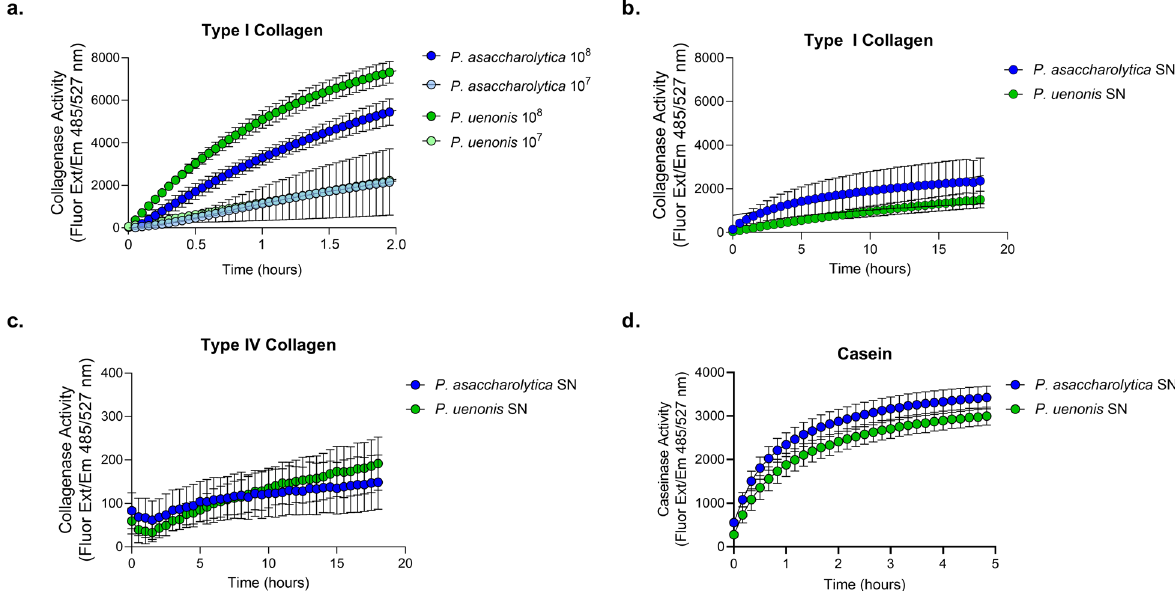
Fig. 1 Proteolytic activity of vaginal Porphyromonas species. a Cell suspensions of P. asaccharolytica and P. uenonis at 10 7 or 10 8 CFU/reaction were incubated with fl uorophore-conjugated type I collagen. Results are presented as mean ± standard error from three independent experiments performed in technical triplicate or quadruplicate. Collagen degradation was measured every 3 min by detecting the increase in fl uorescence over a 2-h time course. b , c Cell-free supernatants of P. asaccharolytica and P. uenonis were incubated with fl uorophore-conjugated b type I or c type IV collagen over an 18-h time course. Results are presented as mean ± standard error from seven independent experiments (type I collagen) and four independent experiments (type IV collagen) performed in technical triplicate. d Cell-free supernatants of P. asaccharolytica and P. uenonis were incubated with fl uorescein (FITC)-conjugated casein over a 5-h time course. Results are presented as mean ± standard error from fi ve independent experiments performed in technical triplicate. The mean fl uorescence readings of the negative control were subtracted from experimental wells and relative fl uorescence units (RFU) were plotted over time, with negative values adjusted to